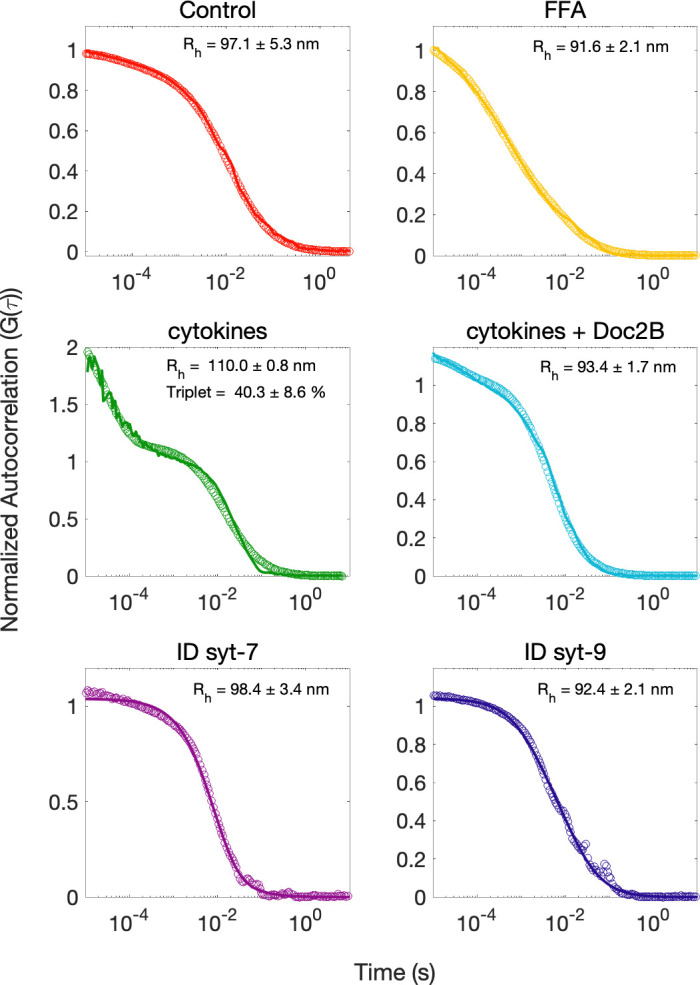
Averaged FCS correlation curves along with curve fits.(Equations 1 and 2) of insulin granules purified from palmitate-treated (FFA), cytokine-treated, and Doc2B-expressing cytokine-treated GRINCH cells or immunodepleted with antibodies against syt7 or syt9, and controls without treatments or immunodepletion are averaged from 20, 30 s runs. The hydrodynamic radius for each curve takes into account variations in temperature and viscosity with errors reported between fits. Fractional triplet component is reported where necessary.